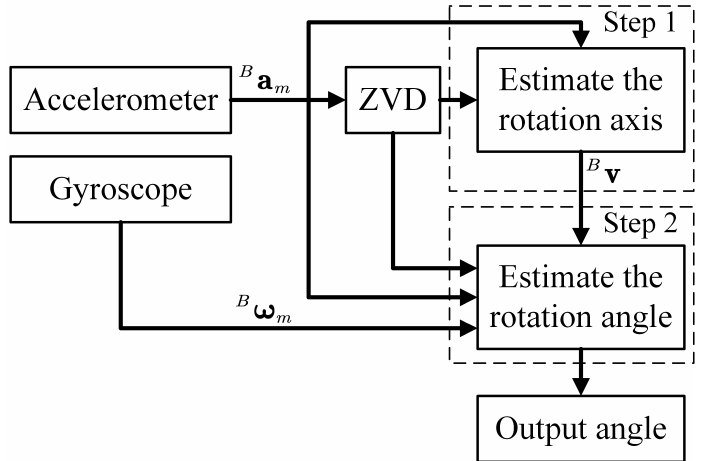
Figure 5. Block diagram for the angle measurement algorithm. Estimating the rotation axis direction requires acceleration data and the results of zero-velocity detection (ZVD). Estimating the rotation angle requires acceleration data, angular velocity data, rotation axis direction, and the results of ZVD.